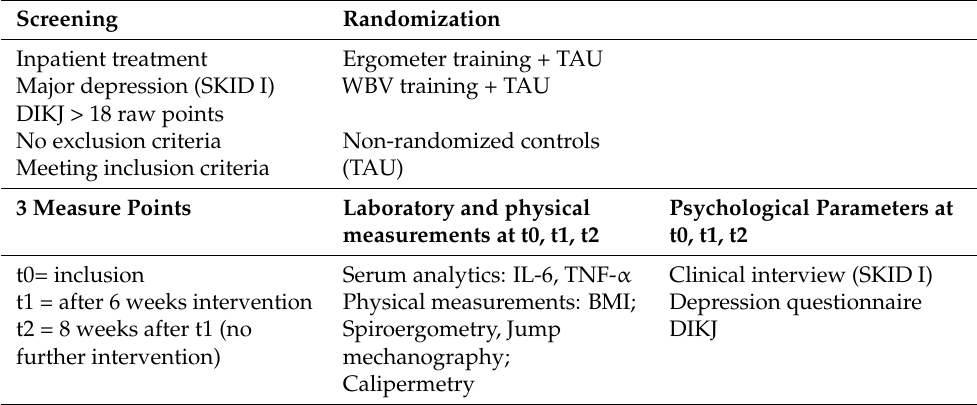
Table 1. Schematic representation of study